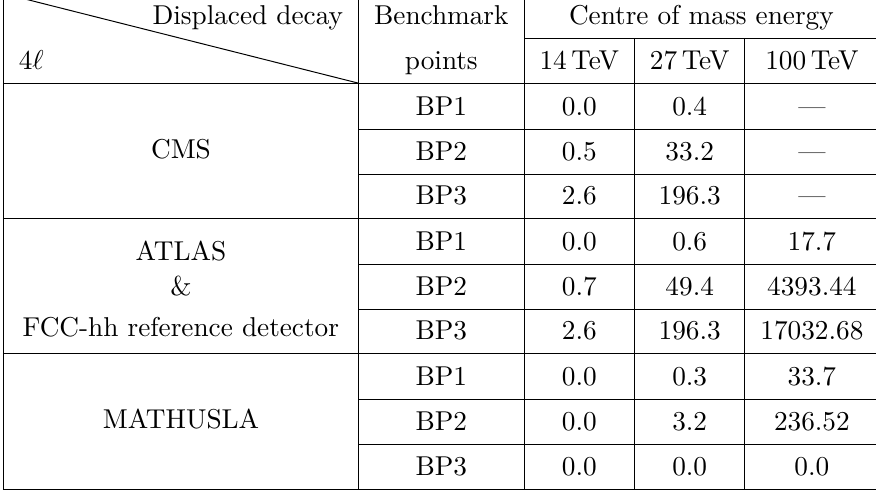
Table 8. Number of events in 4 ‘ final state for the benchmark points with the center of mass energies of 14 TeV, 27 TeV and 100 TeV at the integrated luminosities of 3 ab − 1 , 10 ab − 1 and 30 ab − 1 , respectively. The numbers are given separately for CMS, ATLAS, FCC-hh reference detector (for 100 TeV) and